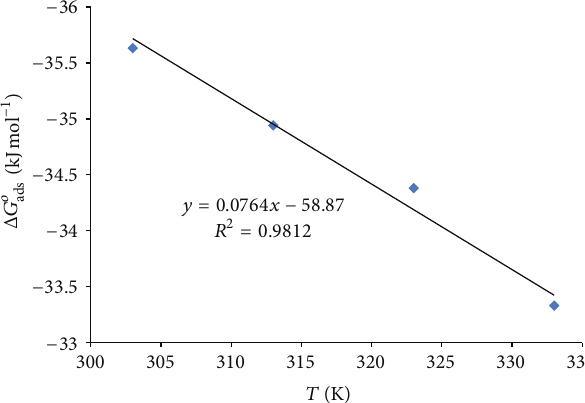
Figure 4: The relationship Δ𝐺 𝑜